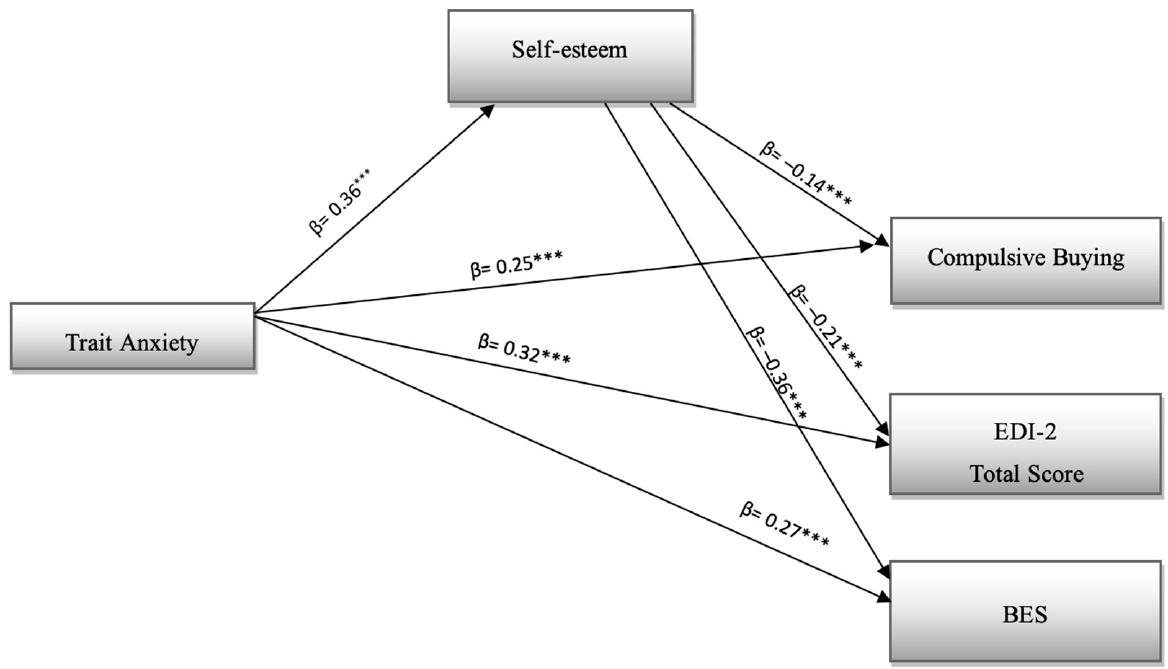
Figure 1. Mediation analysis. *** p < 0.001.